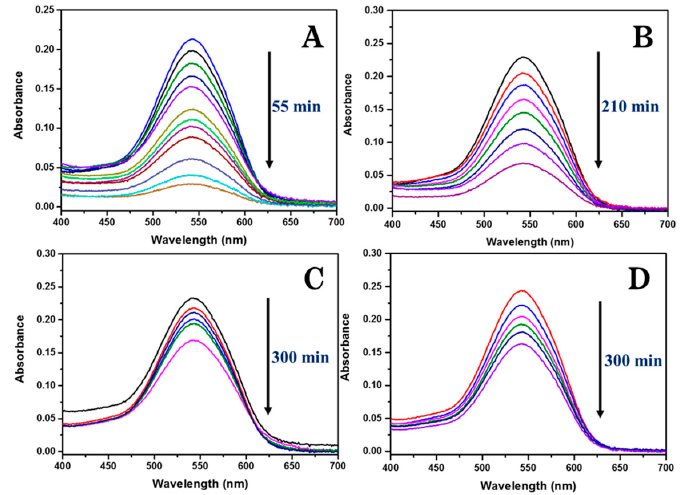
Figure 4. UV–visible spectra recorded during the adsorption of Cr (VI) in the presence of ( A ) G/PANI/FG1; ( B ) G/PANI/FG2; ( C ) G/PANI/FG3; and ( D ) PANI/GNG adsorbent (20 mg), Cr (VI) = 0.5 mM, pH = 2, and temperature = 25 °C.